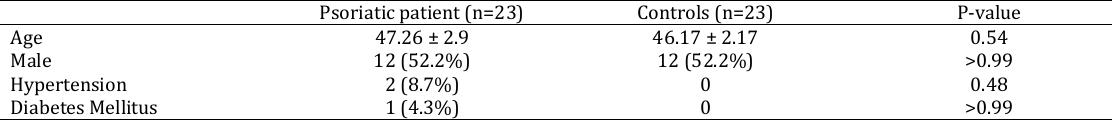
Table 1 . Demographic Characteristics of Participants